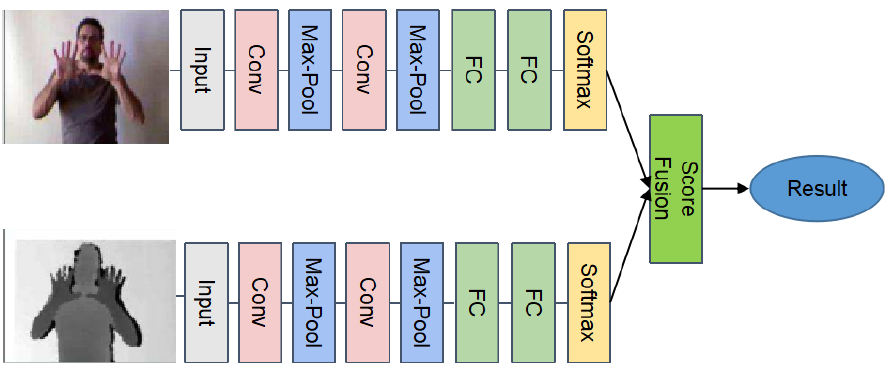
Figure 5. Two stream Convolutional Neural Networks (CNNs) for temporal segmentation.